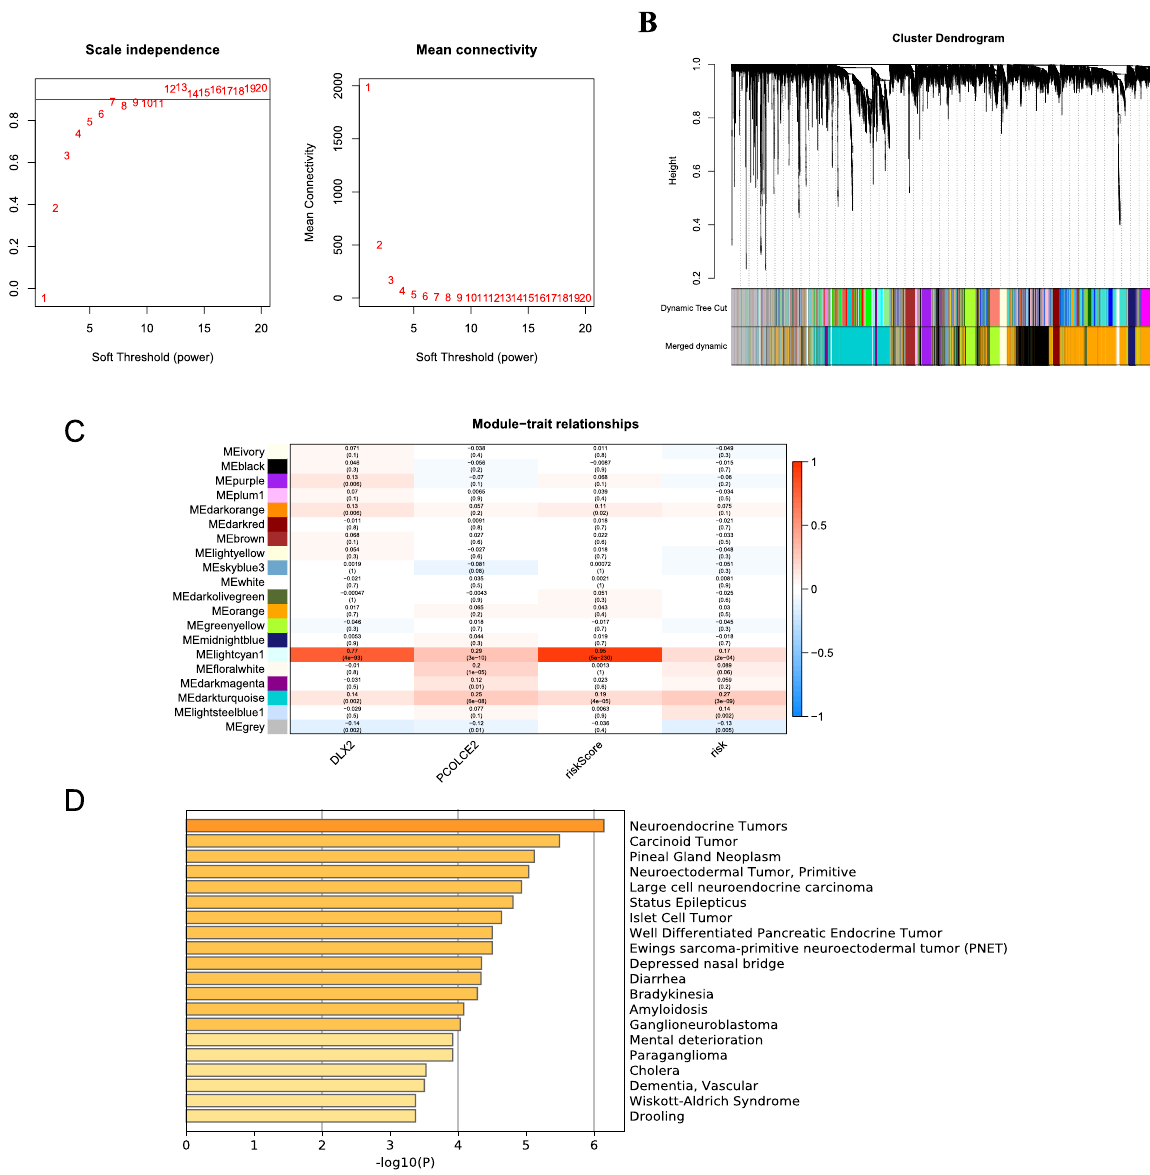
Figure 7. Weighted gene co-expression network analysis. ( A ) Soft-thresholding filtering. ( B ) Module screening, 20 modules have been identified. ( C ) The relationship between the 20 modules and the clinical traits. The numbers in rectangles indicate the correlation coefficient and the numbers in brackets indicate the P value. ( D ) Bar graph of enriched pathway of 43 genes in MElightcyan1